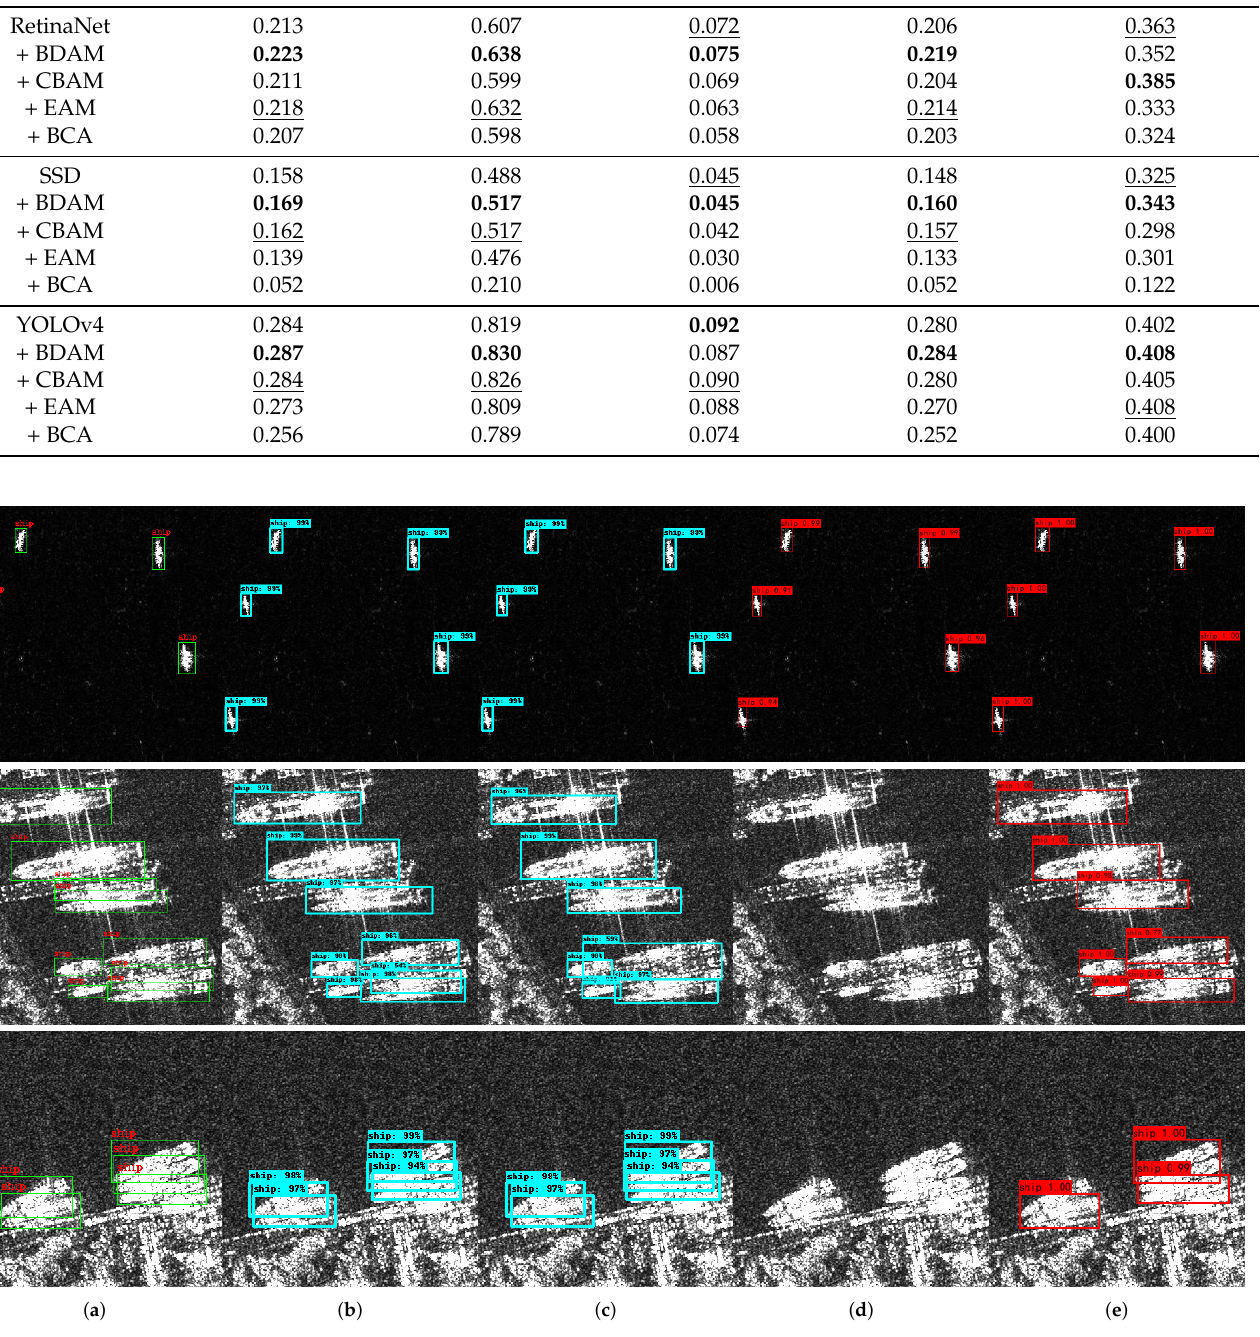
Figure 10. Ground truth and recognition results of some images. ( a ) Ground truth. ( b ) Faster R-CNN. ( c ) Faster R-CNN with BDAM. ( d ) YOLOv4. ( e ) YOLOv4 with